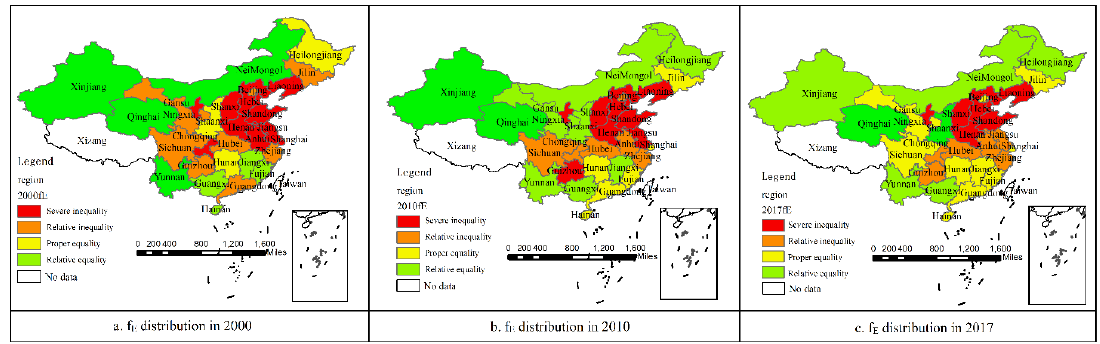
Figure 4. f E distribution of China’s Provinces in 2000, 2010 and 2017.